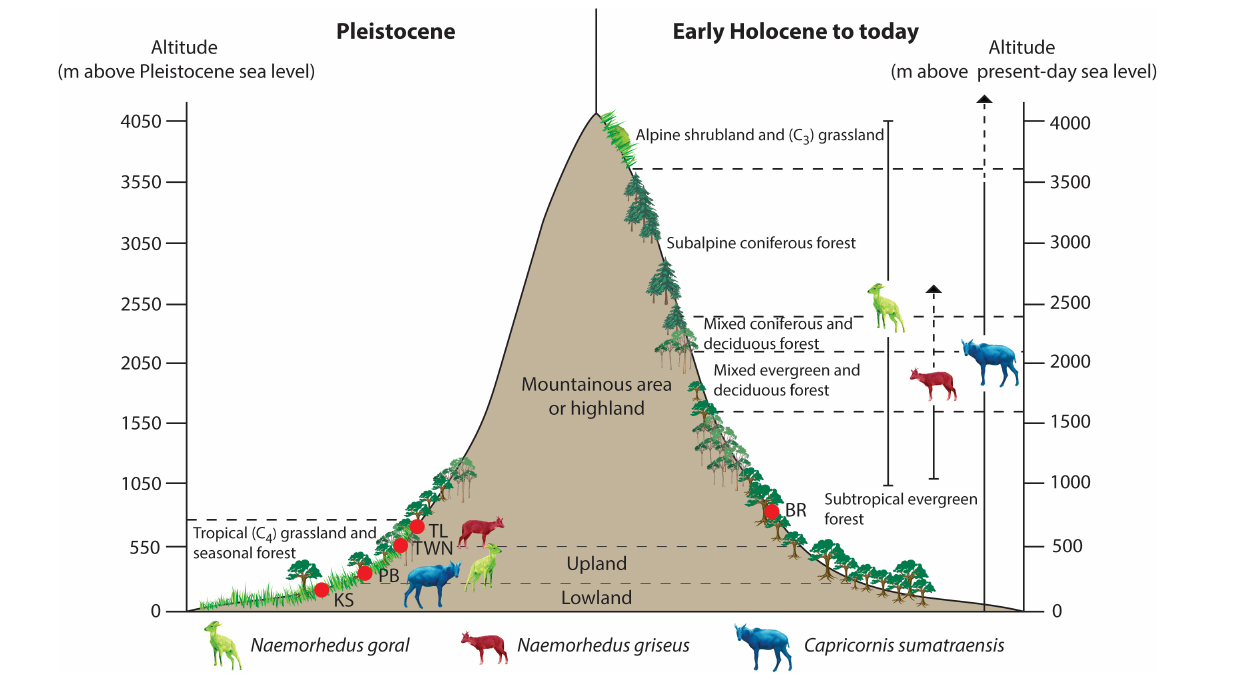
FIGURE 5 | A comparison between Pleistocene and Early Holocene to present-day caprine altitude ranges in relation to major ecosystem distributions in subtropical and tropical regions. For this graphic (as an example), the boundaries of altitudinal vegetation zones are briefly given according to this study for the Pleistocene in Thailand and to Chen et al. (2009, 2012) for the Holocene in Southwest China. The vegetation types and altitudinal zonation may vary along different regions where each caprine taxon is living (i.e., Southeast Asia, Indian Himalayan regions, and Southwest China). Locality abbreviations: PB = Pha Bong, KS = Khok Sung, TWN = Tham Wiman Nakin, TL = Tham Lod Rockshelter, and BR = Ban Rai Rockshelter. The intermediate lowered sea level of 50 m below the present-day level during glacial stages is applied for the Pleistocene